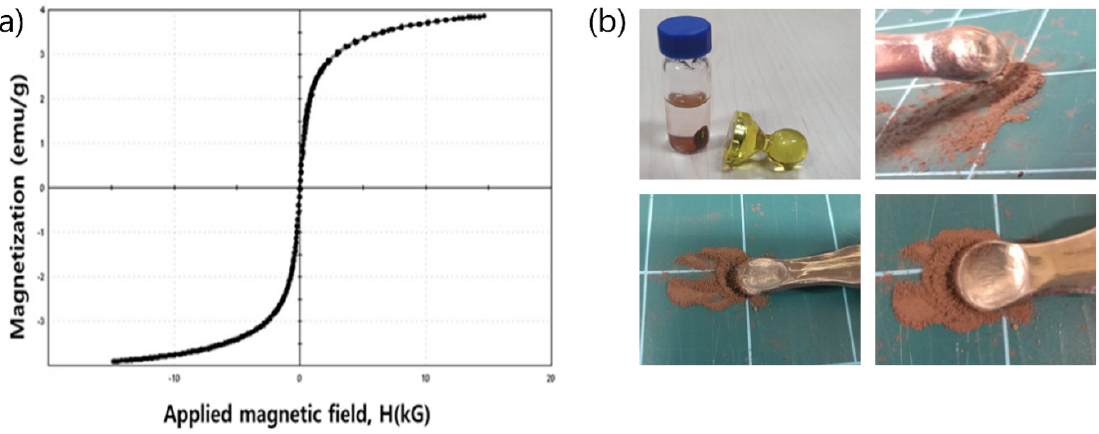
Figure 2. ( a ) Magnetic hysteresis loop of BiFeO 3 . ( b ) Optical photograph of magnetic properties of the BiFeO 3 .